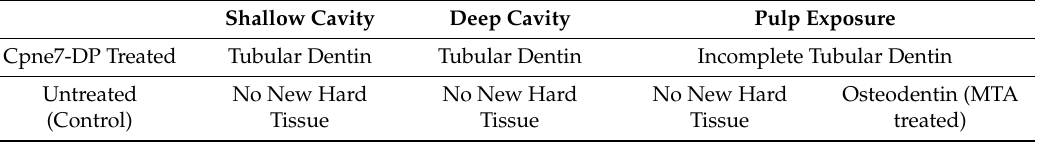
Table 4. Summary of the in vivo canine model results.